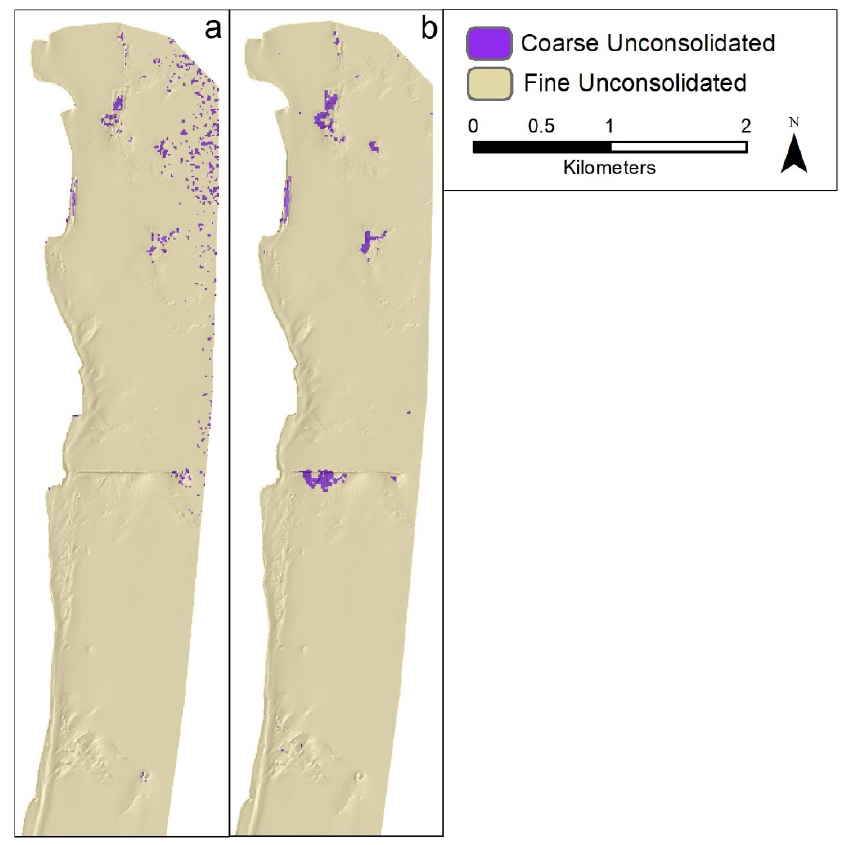
Figure 14. Tier 1 substrate component classification results using satellite data combinations for the north-central section of the study area: ( a ) S2 MS + S2 DII + S2 SDB and ( b ) S2 MS + S2 DII + S2 SDB with additional ROIs.